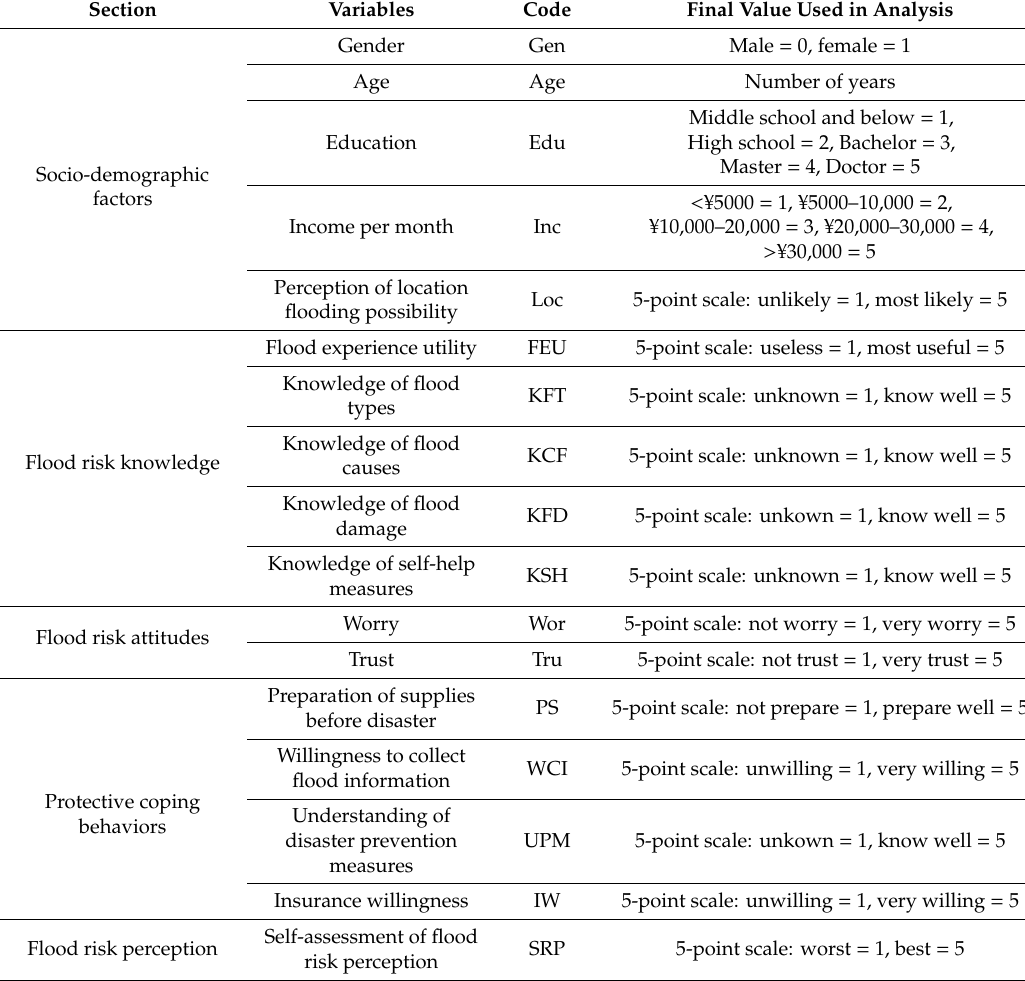
Table 1. The contents of